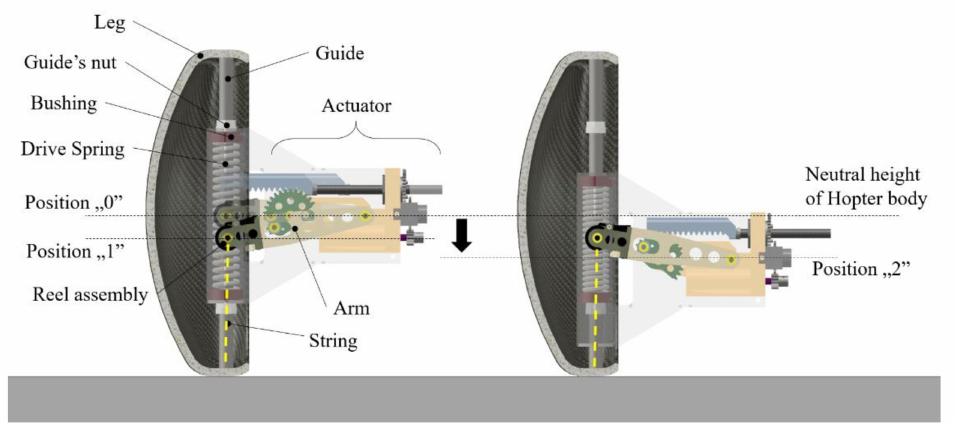
Figure 2. Visualization of the actuator in a neutral position ( left ) and tensioned ( right